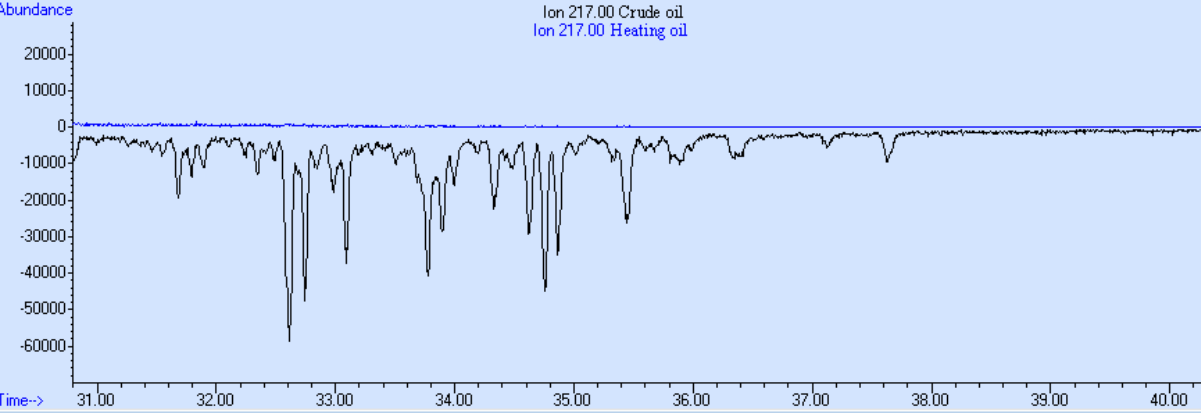
Figure 5. Comparison of EIC at m/z 191 between crude oil and banker oil samples. Figure 6. Comparison of EIC at m/z 217 between crude oil and heating oil samples.